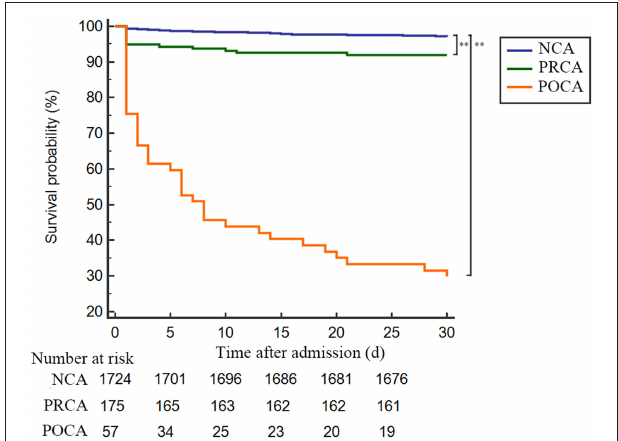
FIGURE 2 | Kaplan–Meier plot of 30-day survival probability of AMI patients underwent emergency PCI stratified by timing of cardiac arrest. Admission to 30-day survival curves for NCA patients (blue line), PRCA patients (green line) and POCA patients (orange line). ** p < 0.001. AMI, acute myocardial infarction; NCA, non-cardiac arrest; PCI, percutaneous coronary intervention; POCA, post-revascularization cardiac arrest; PRCA, pre- revascularization cardiac